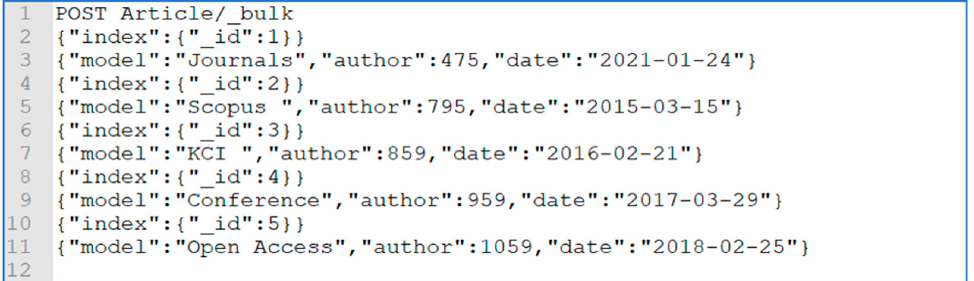
Figure 2. Article query index.